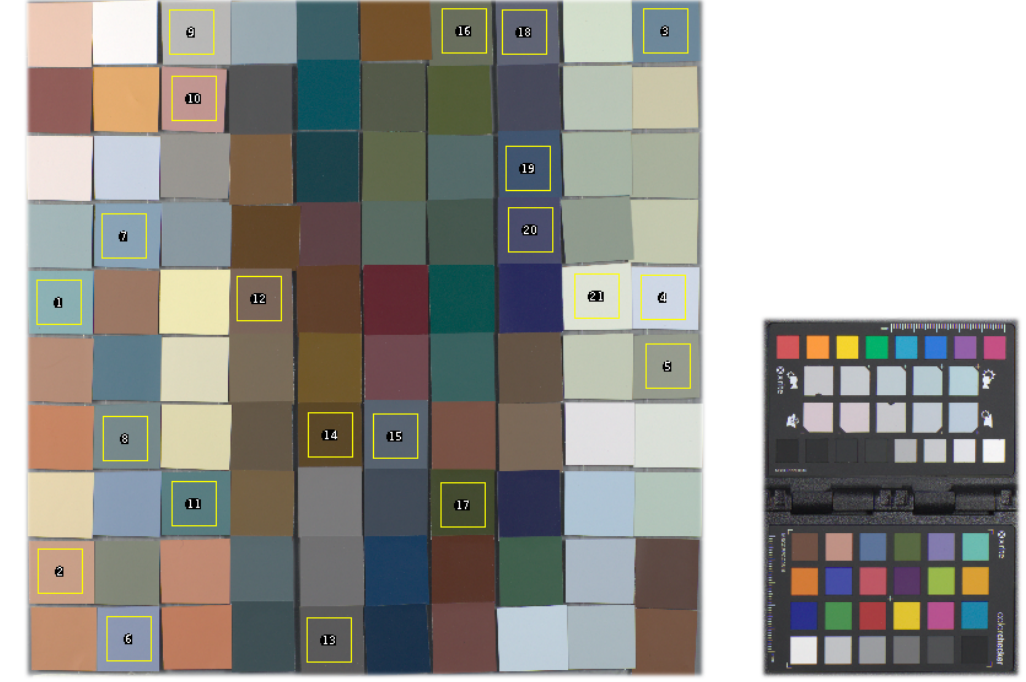
Figure 4. Colour calibrated image capture of 100 of the 320 NCS exterior set samples. The highlighted regions (a subset of the colours in Table A3) were compared for deviations against colorimetric readings to verify the accuracy of the image capture and colour calibration workflow in preparation for computational